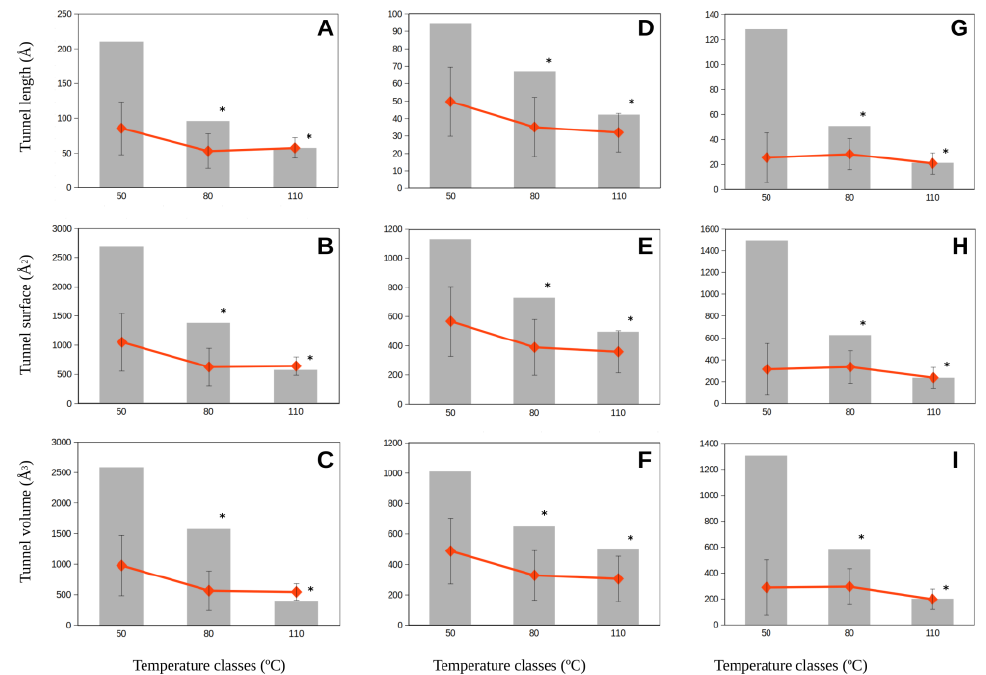
Figure 4. Amplitude and average of the molecular tunnel dimensions, length ( A , D , G ), surface ( B , E , H), and volume ( C , F , I ) (in Å), predicted for the methyl-coenzyme M reductase (Mmr) subunit genes, alpha ( A , B , C ), beta ( D , E , F ), and gamma ( G , H , I ) from methanogenic Archaea classified in three classes of optimum growth temperature (<50 ◦ C; 50–80 ◦ C; >80 ◦ C). Gray bars correspond to the amplitude of data observed for estimates of the molecular tunnel dimensions. Red squares represent the average dimensions for each growth temperature class. Error bars represent the standard deviation around the average values. Asterisks denote statistical significance ( p < 0.05) with respect to the temperature class <50 ◦